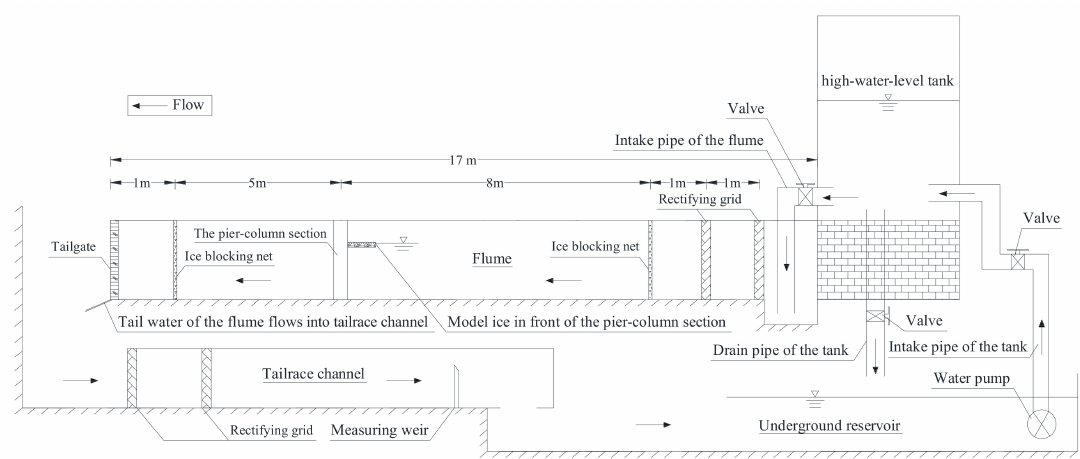
Figure 1. Elevation diagram of test